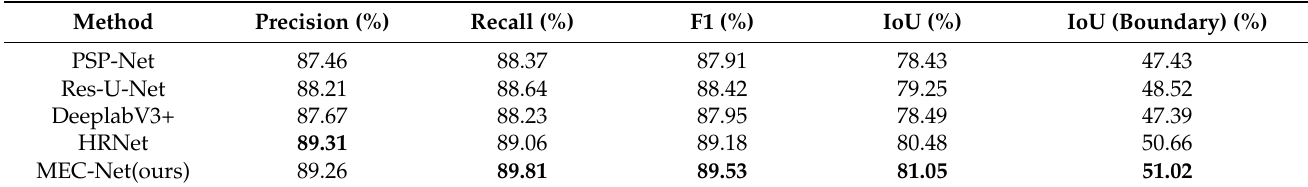
Table 4. Quantitative evaluation of MEC-Net using the Inria dataset.